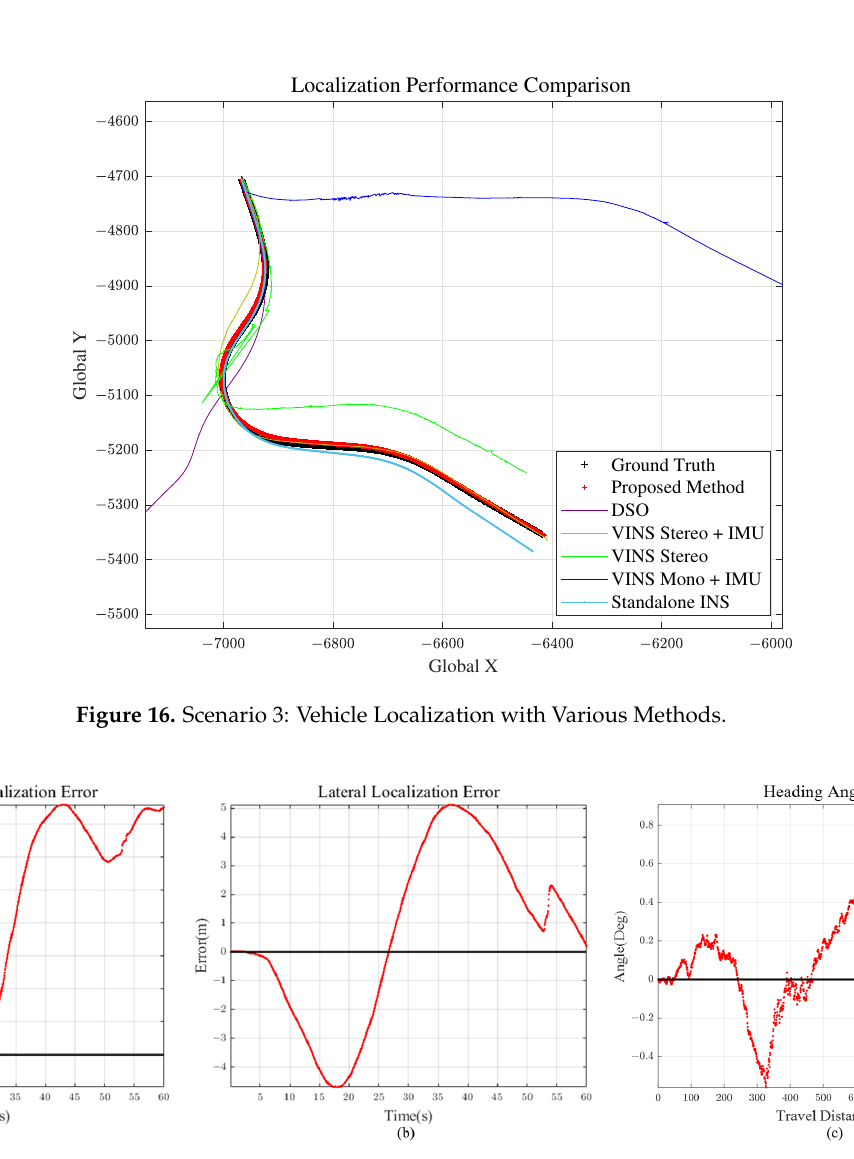
Figure 17. Scenario 3 (90 m Preview) ( a ) Longitudinal Error ( b ) Lateral Error ( c ) Heading Angle Drift. Table 3. Scenario 3 Localization Results (Trajectory Length: 1077